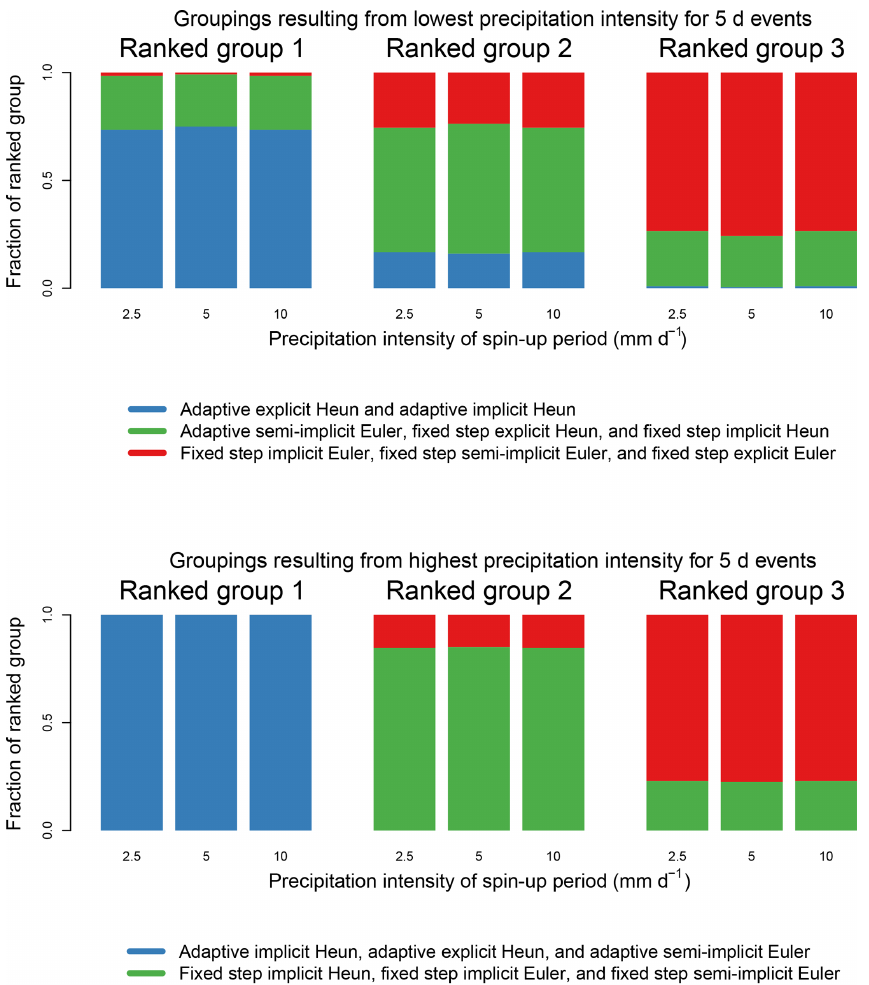
Figure 6. The robustness of rankings of numerical techniques in RMSE for high and low precipitation intensity events for three different initial conditions. A ranking is more robust when a selection of numerical methods is prevalent in a given ranked group, indicated by the predominance of a single color in a ranked group. All adaptive methods here use FUSE default error tolerances. These results incorporate hydrographs generated across five model structures and 20 parameter sets. Different rankings are observed for high and low precipitation